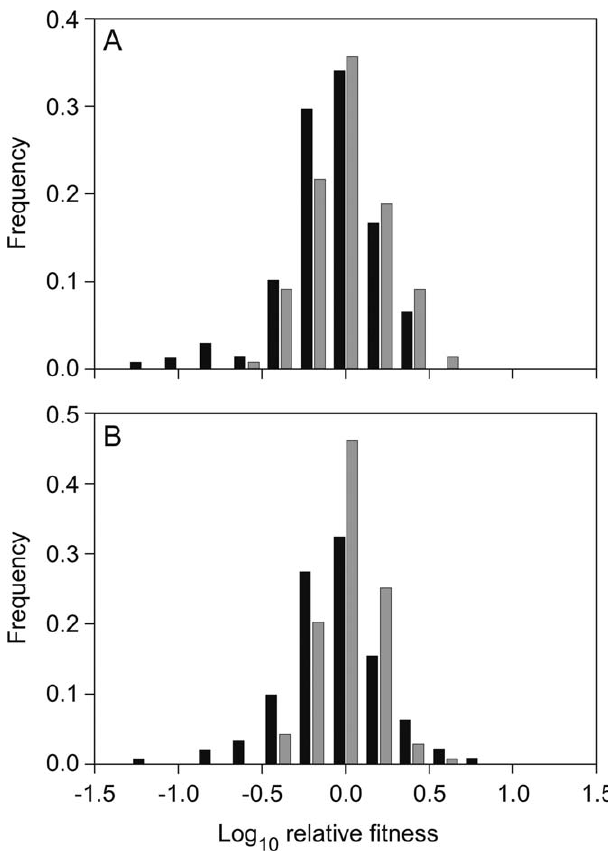
Figure 3. Mutation Accumulation (A) Fitness measurements of the high-fitness MA lines. The fitness values of the parents are shown in gray, the offspring in black. Note that all fitness values for each MA experiment were scaled such that the mean of the parental log 10 fitness values was zero; this was done so that the error in fitness measurements was approximately normal, and so all three separate experiments in the low- and high-fitness lines could be combined on the same axis. (B) Fitness measurements of the low-fitness MA lines. Shading and scaling are the same as in (A). In both (A) and (B), a considerable shift to the left (lower fitness) can be observed after a single round of mutagenesis. In the low-fitness lines, several offspring clones with fitness greater than the parental clones can be observed. In the high-fitness lines, no such offspring clones are